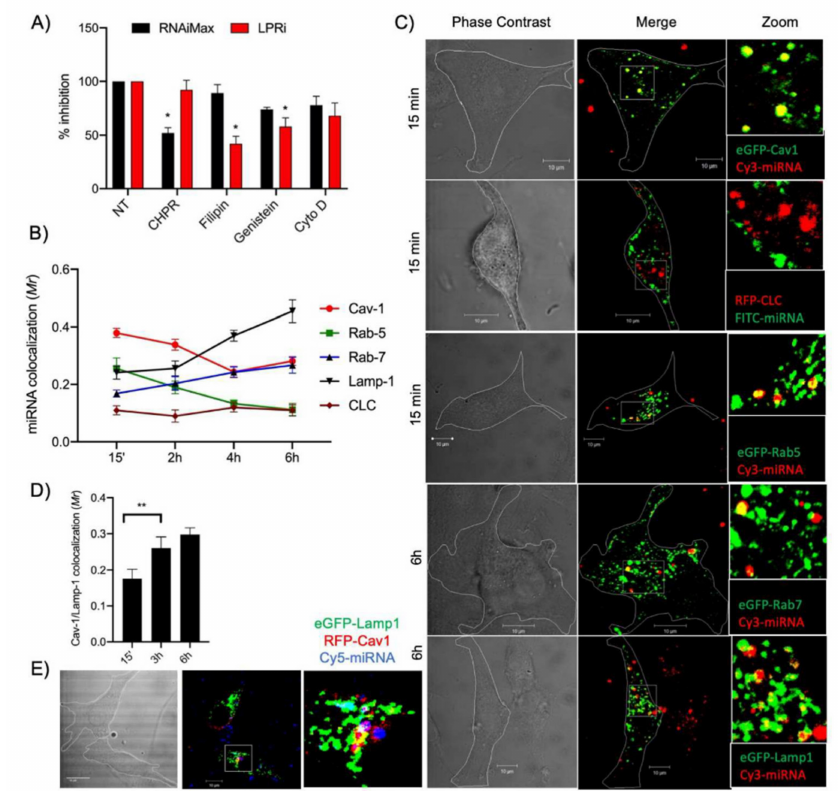
Figure 3. Intracellular trafficking of miRNA-133a. ( A ) U87MG LentiRILES/133 T cells were pre- incubated with specific inhibitors of the caveolae (Fillipin and Genistein), clathrin (Chlorpromazine, CHPR) and macropinocytosis (cytochalasin D, Cyto D) internalization pathways before miRNA-133a transfection with LPRi or RNAiMax. Then, 48 h later, the luciferase activity in cells was quantified ( n = 3). ( B ) U87MG cells expressing eGFP-Cav1, RFP-CLC, eGFP-Rab5, eGFP-Rab7 or eGFPLamp1 were transfected for 1 h (pulse) with LPRi.Cy3-miRNA-133a then washed and further incubated for 15 min, 2, 4 or 6 h, fixed in 3% PFA and analyzed by confocal microscopy analysis ( n = 4). ( C ) Representative images from eGFP-Cav1, RFP-CLC and eGFP-Rab5 cells collected at a 15-min time point and from eGFP-Rab7 or eGFP-Lamp1 cells collected at a 6 h time points. ( D ) Quantification of co- localization events between RFP-Cav1 and eGFP-Lamp1 detected at 15 min, 3 and 6 h postincubation ( n = 3). ( E ) Co-localization of LPRi.Cy5-miRNA-133a with RFP-Cav1 and eGFP-Lamp1 after 3 h incubation ( n = 3). For all panels, values are mean ± SEM; * p < 0.05, ** p < 0.01; Reproduced with permission from Elsevier